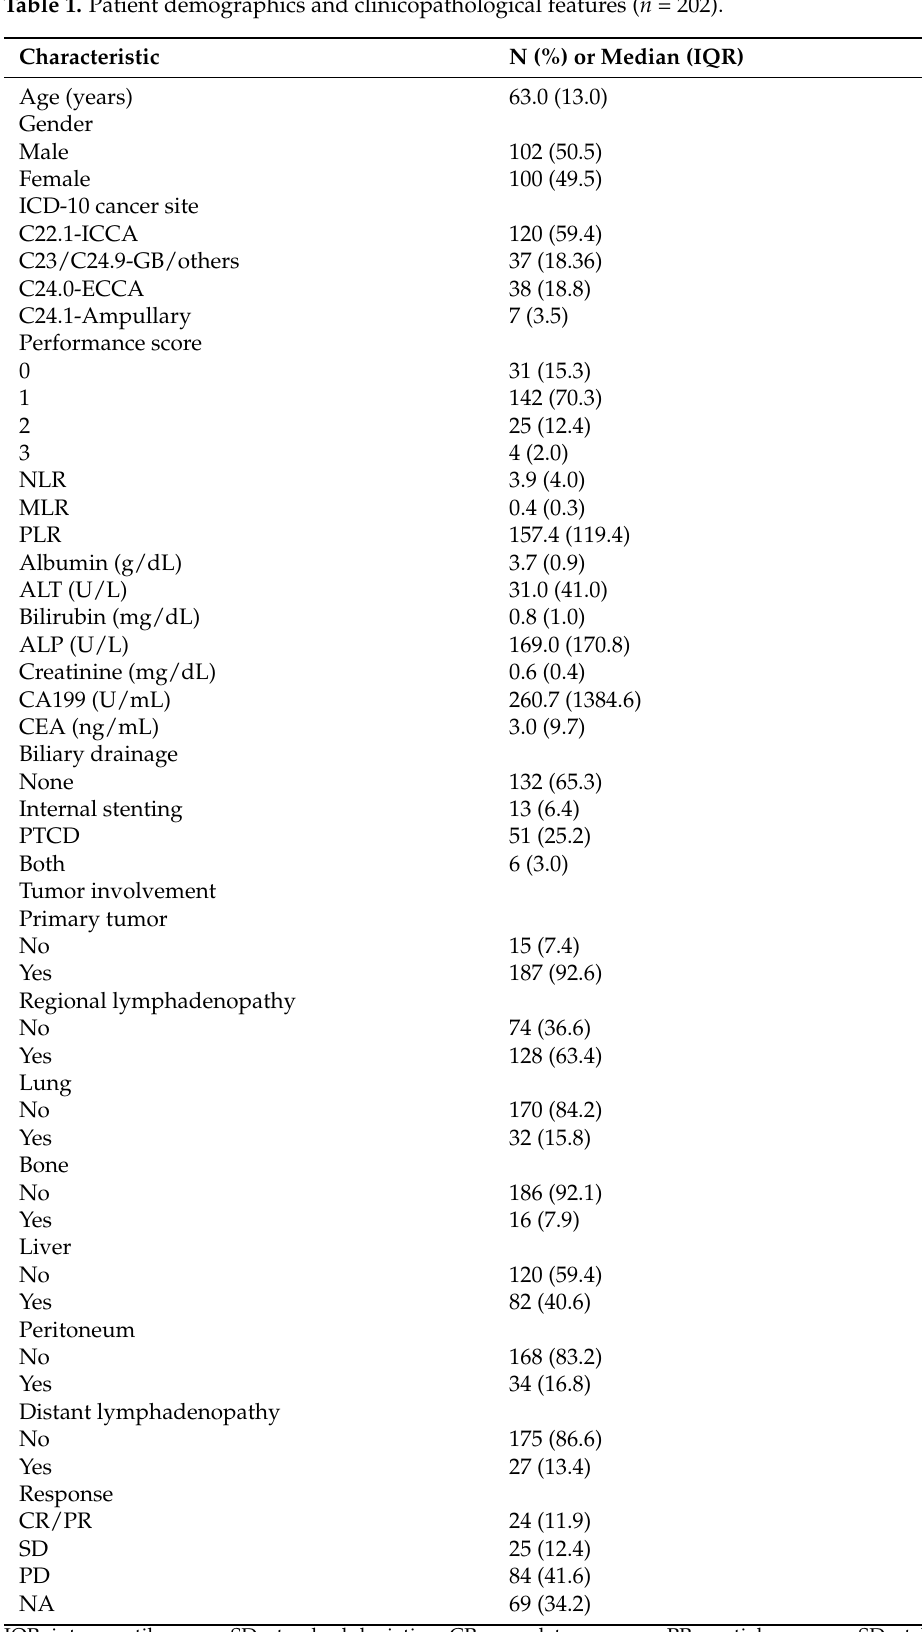
Table 1. Patient demographics and clinicopathological features ( n =